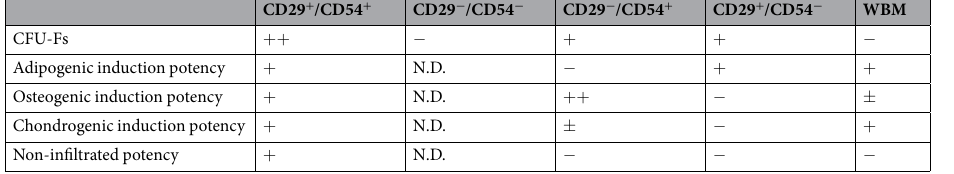
Table 1. Summary of the MSC potency of BM-derived sub-populations. Self-renewal ability was evaluated as follows: ++ , > 20 colonies; + , > 10 colonies; and − , ≤ 1 colony in a 96-well plate (related to Fig. 1c). For differentiation abilities, the staining and mRNA expression data were evaluated as follows: ++ , stained positively and demonstrated 50-fold higher expression; + , stained positively and demonstrated 2-fold higher expression; ± , stained positively and tended to demonstrate higher expression of the differentiation marker than the subset in which expression was lowest; and − , not stained and demonstrated the lowest mRNA expression level (related to Supplementary Fig. 4). Macrophage infiltration was evaluated as follows: + , macrophages not seen in the transplanted area; and − , macrophages infiltrated into the graft (related to Fig.